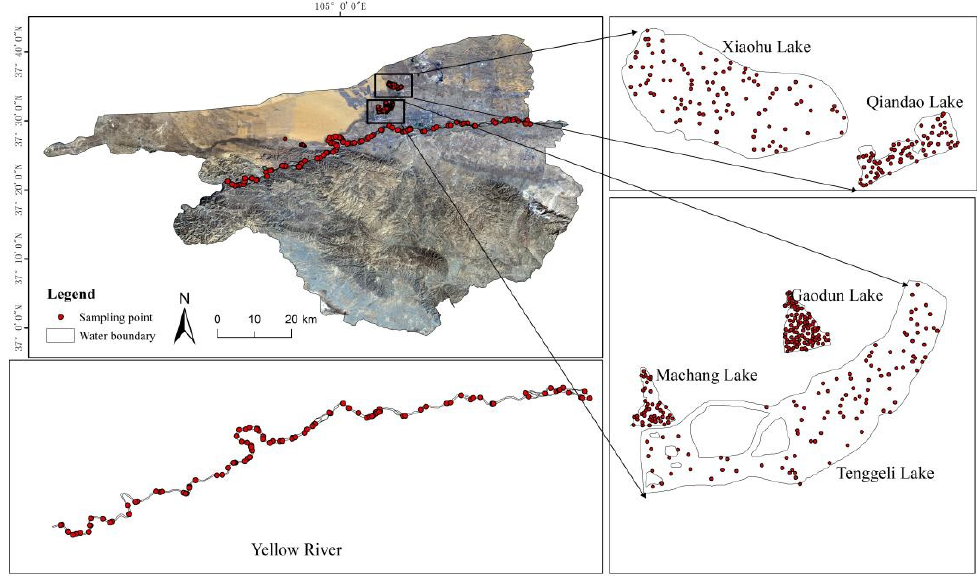
Figure 5. Sample point example (The sample points are shown in the figure).